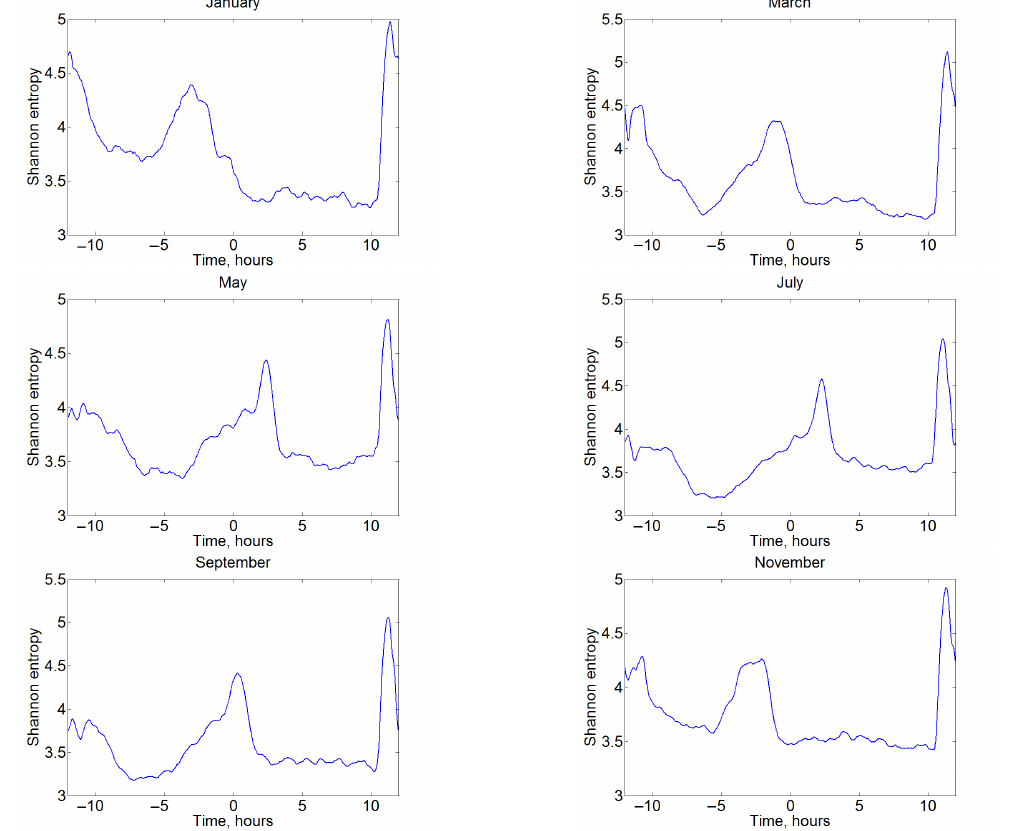
Figure 10. Variations in the monthly mean of information entropy at the AKT station in 2014, centered at the time of sunset. VLF amplitude data for January, March, May, July, September, and November are